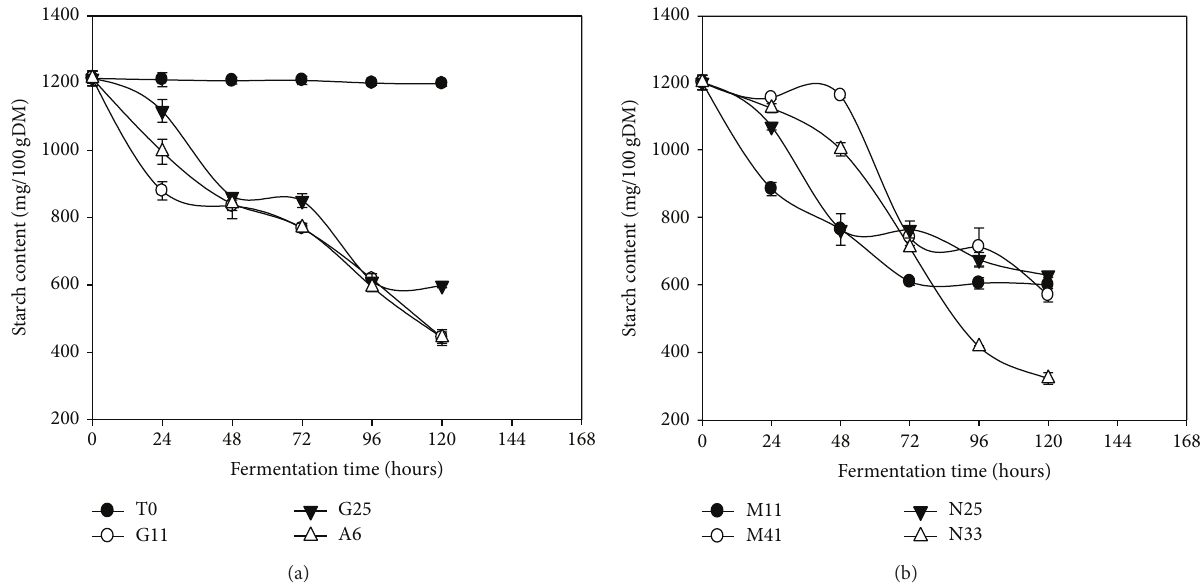
Figure 4: Evolution of the starch content in the Kutukutu during fermentation by the various LAB at 25 ∘ C (T0 = control; G11 = L. brevis G11; G25 = L. brevis G25; A6 = L. plantarum A6; M11 = L. buchneri M1; M41 = L. cellobiosus M41; N33 = L. fermentum N33; N25 = L. fermentum N25).